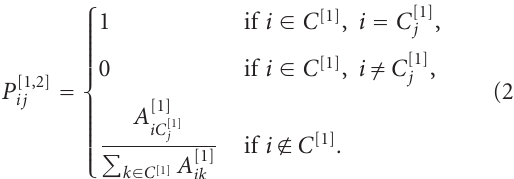
top-down phase of the algorithm, pixels are recursively grouped into increasingly large overlapping blocks. At any level in the process, blocks that are su ffi ciently di ff erent from their neighbours are identified as salient segments. The top-down phase ends when all remaining blocks have become salient. In the second, bottom-up phase of the algorithm, overlapping blocks that were identified as salient are recursively sharpened, until all fine-level pixels are assigned to a unique segment at the top